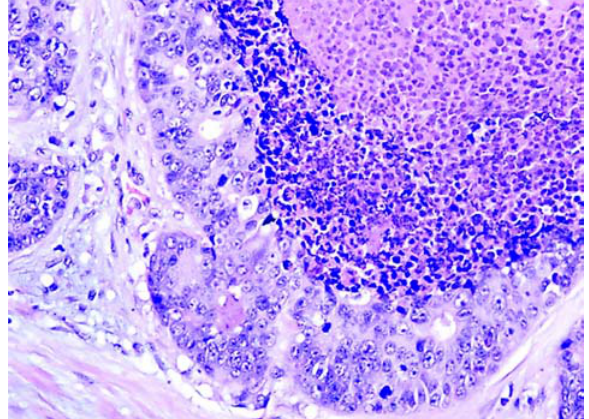
Figure 1 – Prostatectomy with high-grade adenocarcinoma with glandular and cribriform architecture (HE,